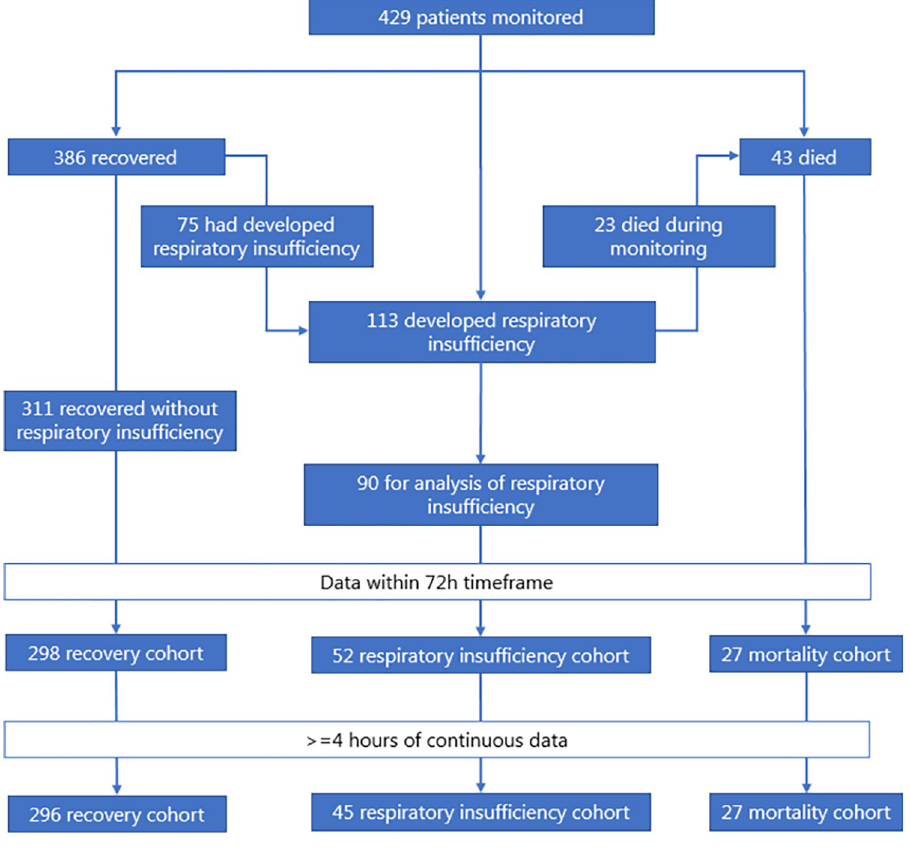
Fig 1. Flowchart of patient inclusion and data